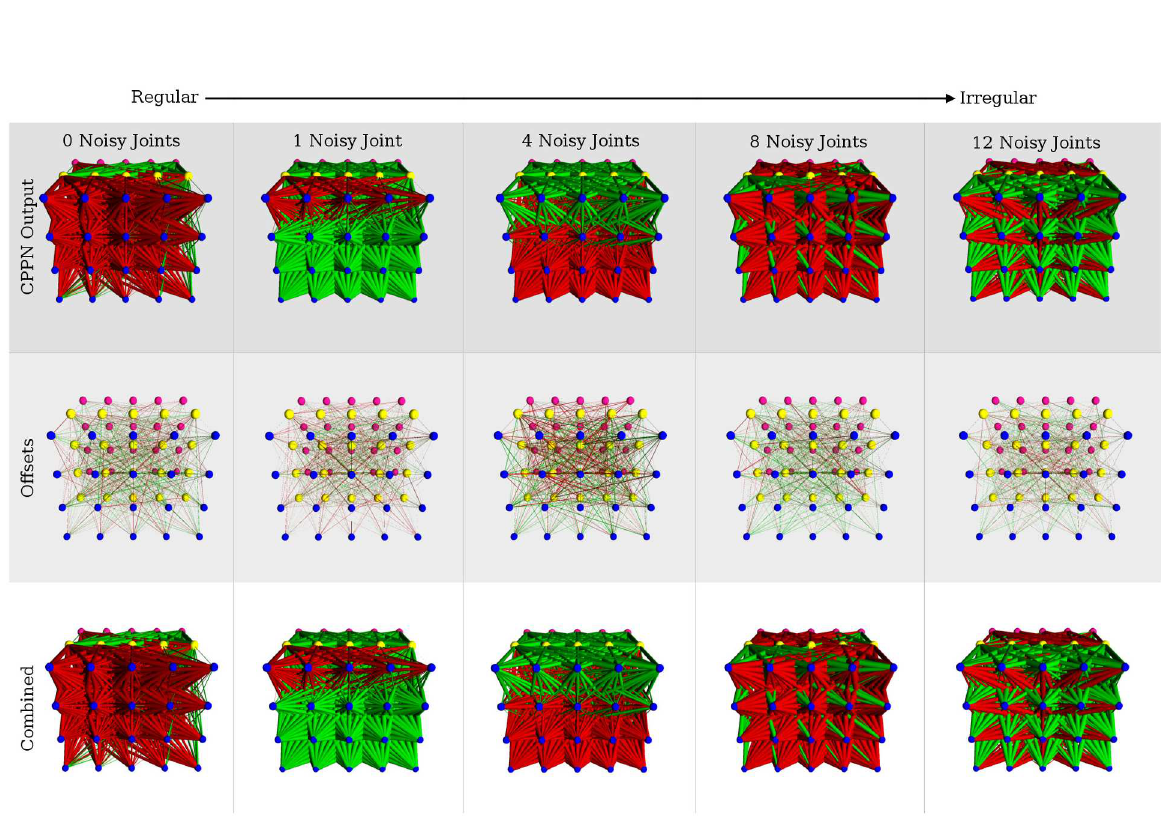
Fig 27. The fittest Auto-Offset-HybrID ANNs from each regularity of the quadruped robot experiment viewed from the output layer. Red links are inhibitory, green links are excitatory, and link weight magnitudeis indicatedby the thickness of the link.